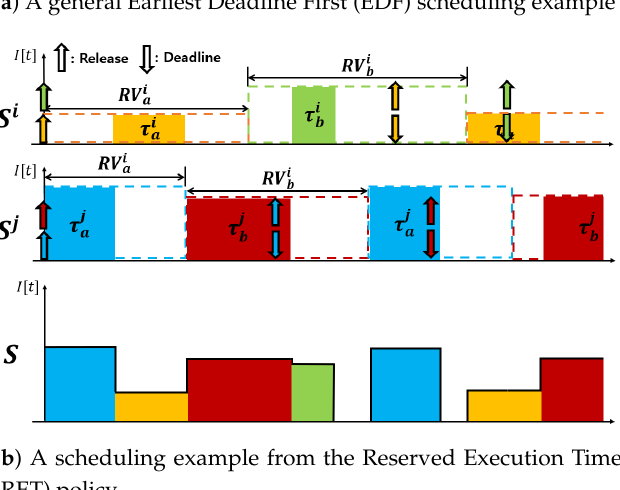
Figure 4. Examples of scheduling and current dissipation traces from ( a ) EDF and ( b ) the RET frame-